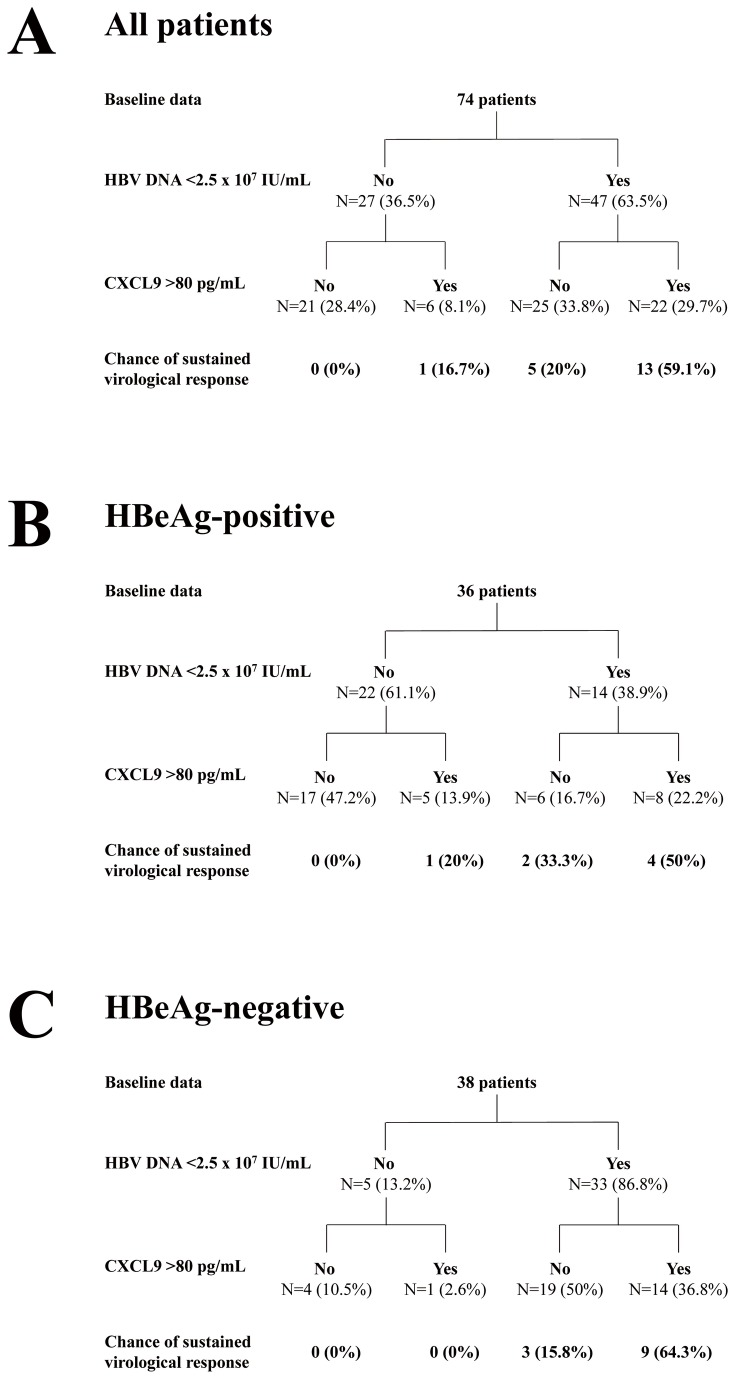
Prediction algorithm based on baseline serum CXCL9 level and HBV viral load.The prediction algorithm applied for all (A), HBeAg-positive (B) and HBeAg-negative CHB patients (C).